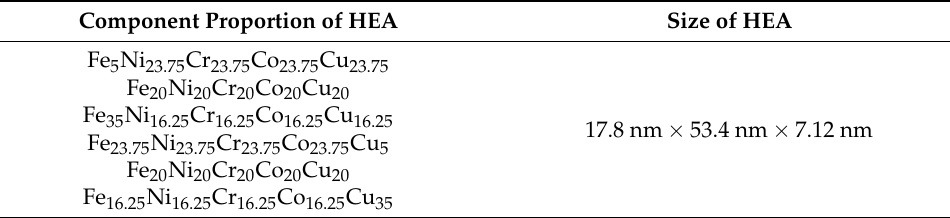
Table 2. Proportion and size of FeNiCrCoCu HEAs with unequal atomic ratio. Component Proportion of HEA Size of HEA